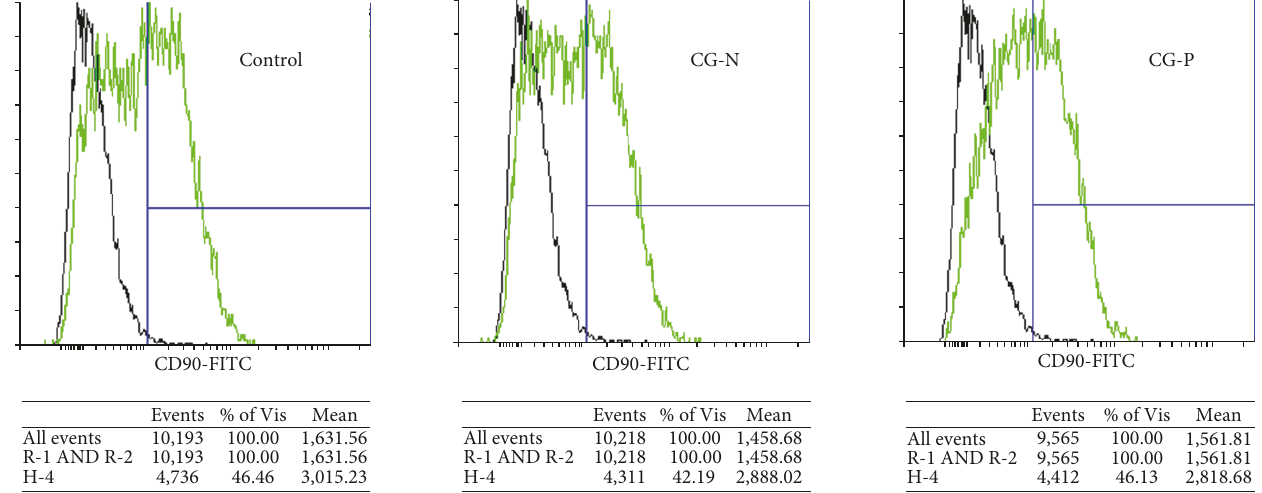
Figure 2: CD90-positive CDC immunophenotype on di ff erent cardiogel substrates. Representative histogram of fl ow cytometry analysis. The immunophenotypes of CG-N and CG-P CDCs were not signi fi cantly di ff erent concerning the abundance of the CD90 + subpopulation, as shown by the representative fl ow cytometry histograms. CG-N: normal cardiogel; CG-P: pathological